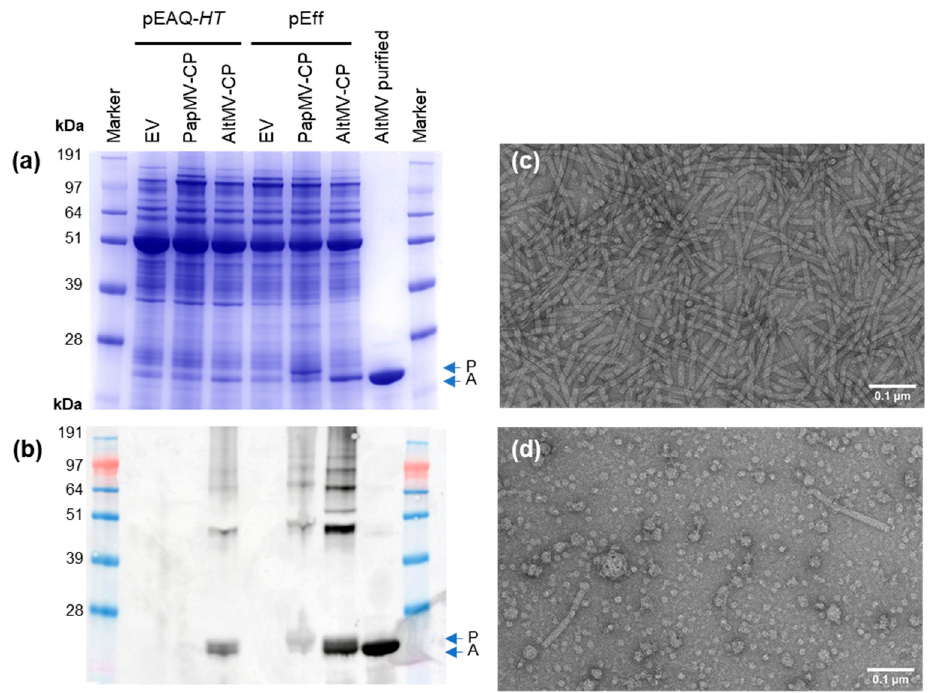
Figure 2. Comparison of expression of potexvirus coat proteins from pEAQ- HT and pEff. Analysis of clarified protein extract by InstantBlue-stained SDS-PAGE ( a ) and whole protein extract by anti-PapMV Western blot (note that anti-PapMV antibody has high affinity for both PapMV-CP and AltMV-CP) ( b ). Samples were from the same infiltration experiment. Transmission electron microscopy (TEM) images of pEff-AltMV-CP after purification ( c ), and pEff-PapMV-CP particles in clarified extract ( d ). EV: empty vector control; AltMV purified: virus-like particles (VLPs) of pEff-AltMV-CP purified using acid treatment and PEG precipitation. Blue arrows show location of bands for PapMV-CP (P) and AltMV-CP (A).